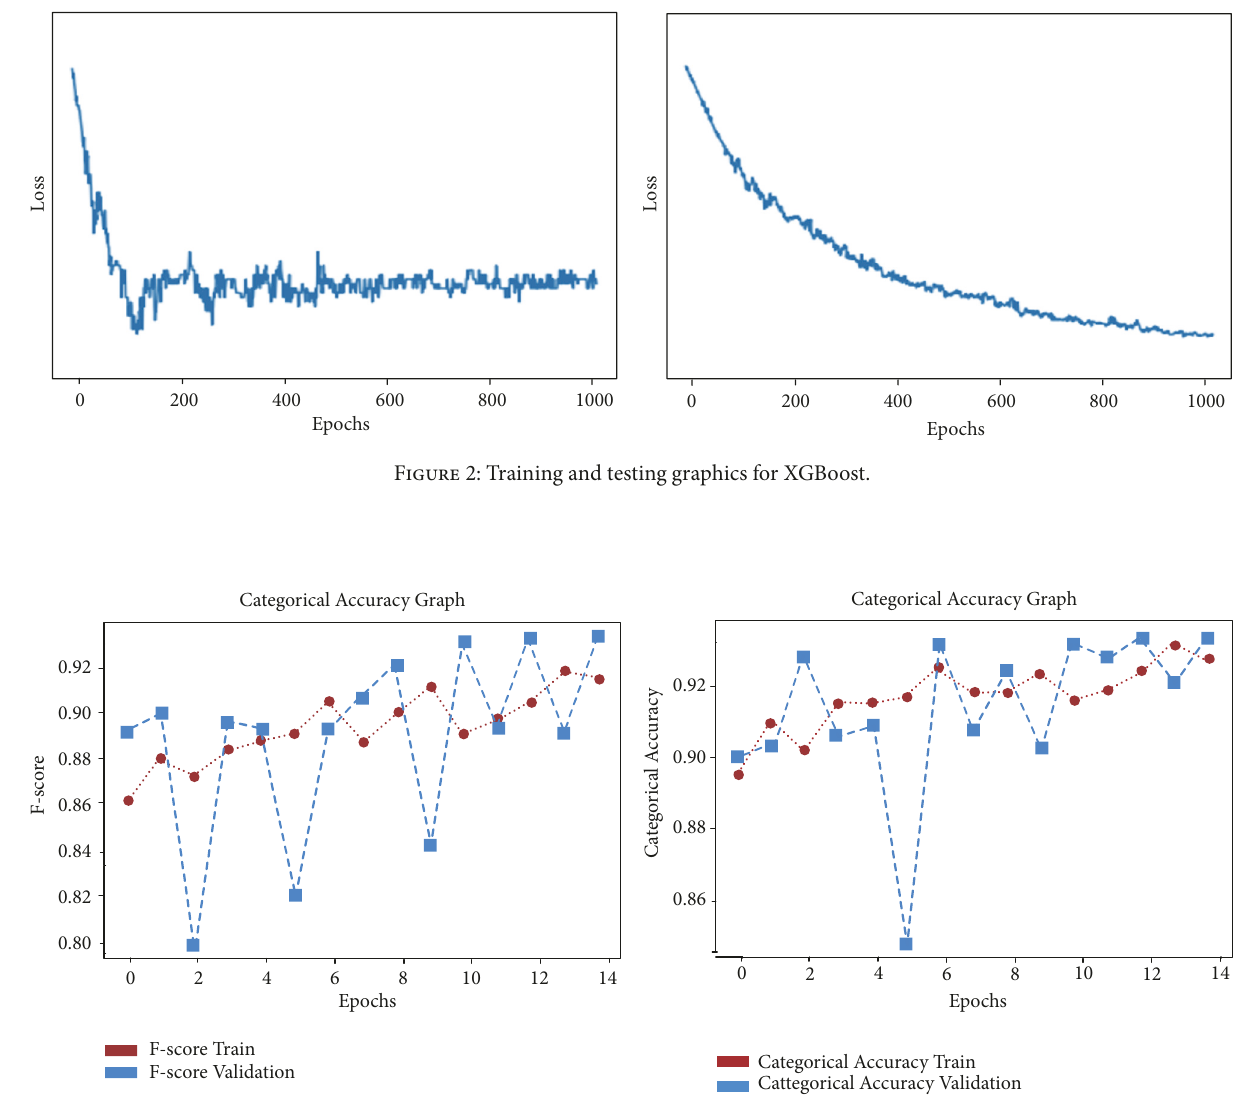
Figure 3: F-beta score and categorical accuracy